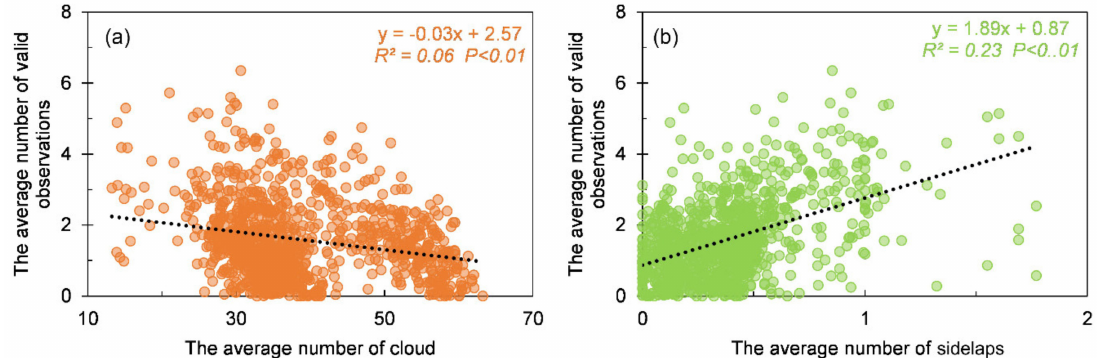
Figure 6. Relationships between spatial valid observations and ( a ) cloud and ( b ) overlap. Data are based on the statistic of three variables of these three rice types at 1 ◦ × 1 ◦ grid. Table 1. Relationships between valid observations and clouds, sidelaps, and transplanting length in China based on Ordinary Least Squares (OLS) regression models. Explanatory Variables Coef. (Std. Err.) Std.